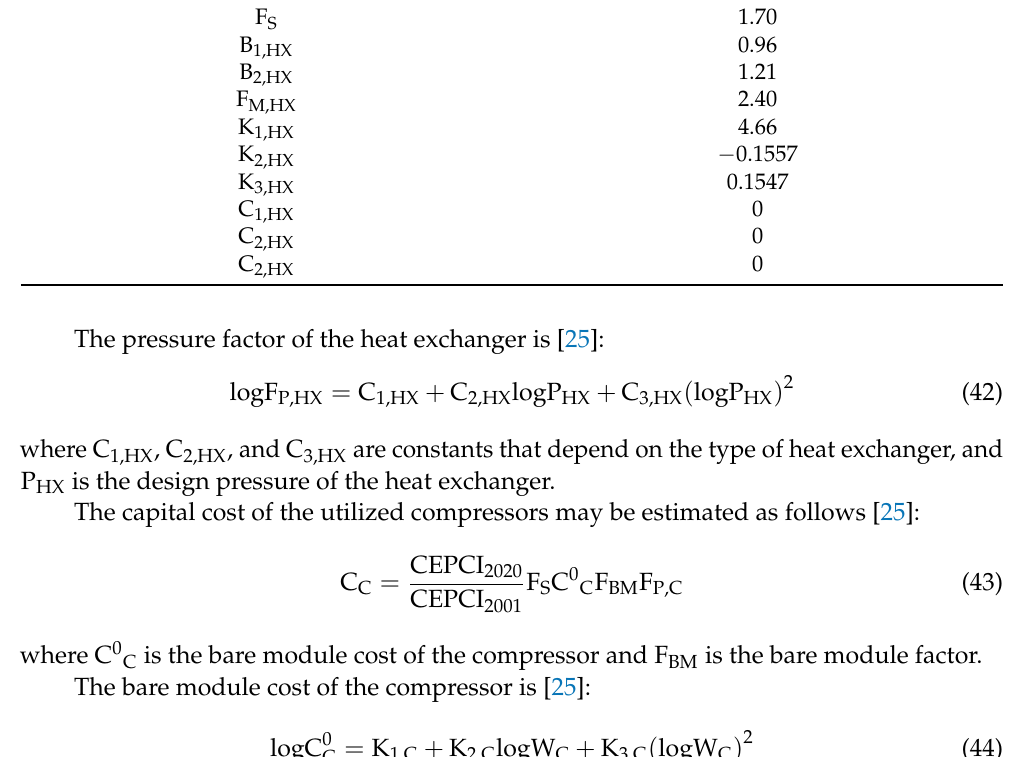
Table 2. Values of constants for estimating the capital cost of the heat exchanger [28]. Constant